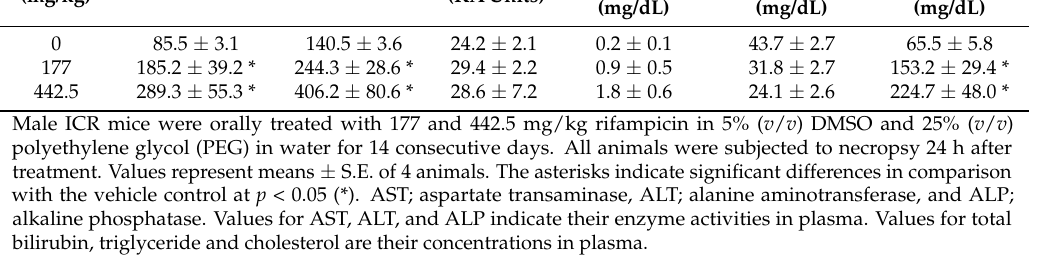
Table 2. Plasma biochemical parameters after rifampicin treatment for 14 consecutive days in male mice. Dose (mg/kg)